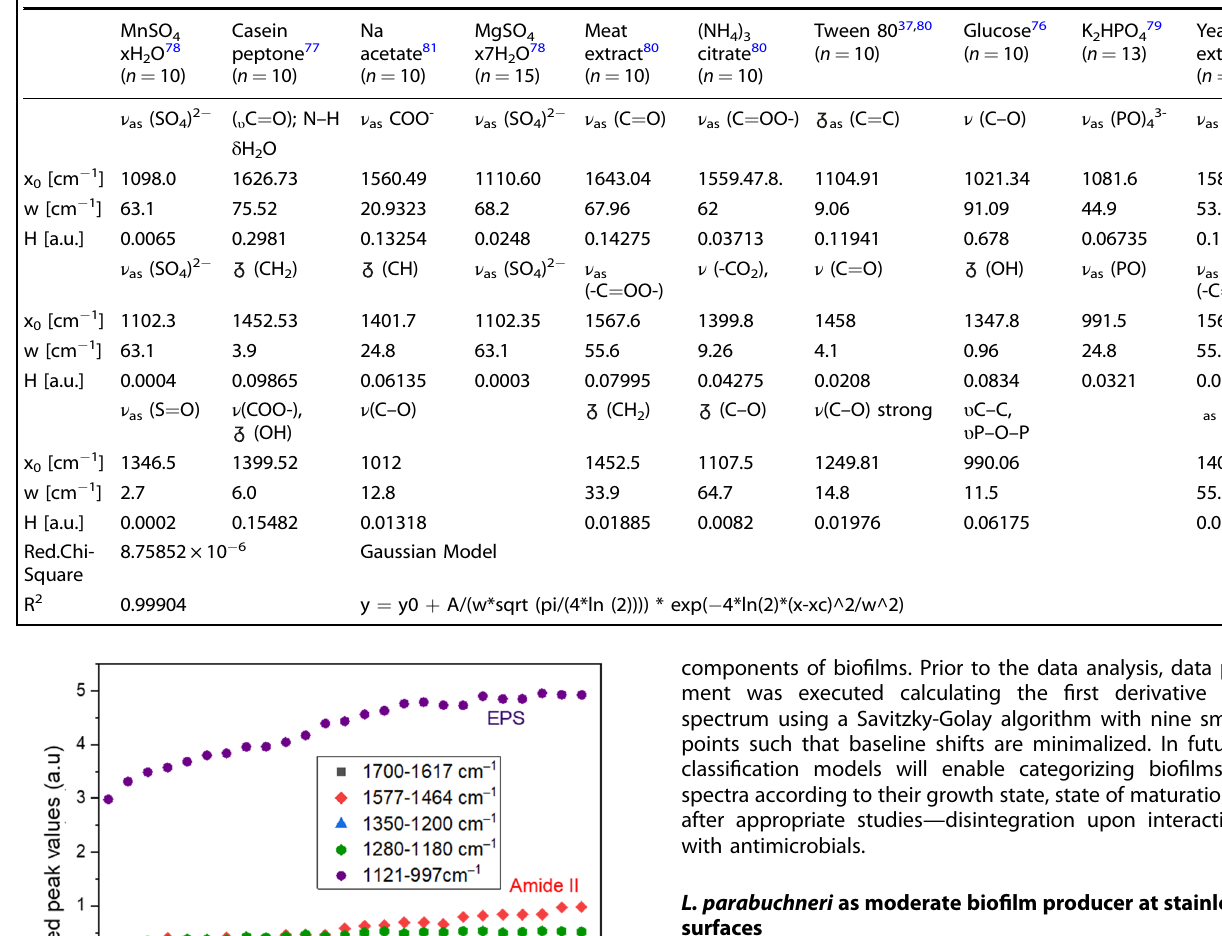
Table 2. Peak attributions of the mean values of individual MRS constituents evaluated for the cumulative impulse fi t obtained via fl ow-through IR- ATR studies along with the statistical result of the Gaussian cumulative impulse fi t.